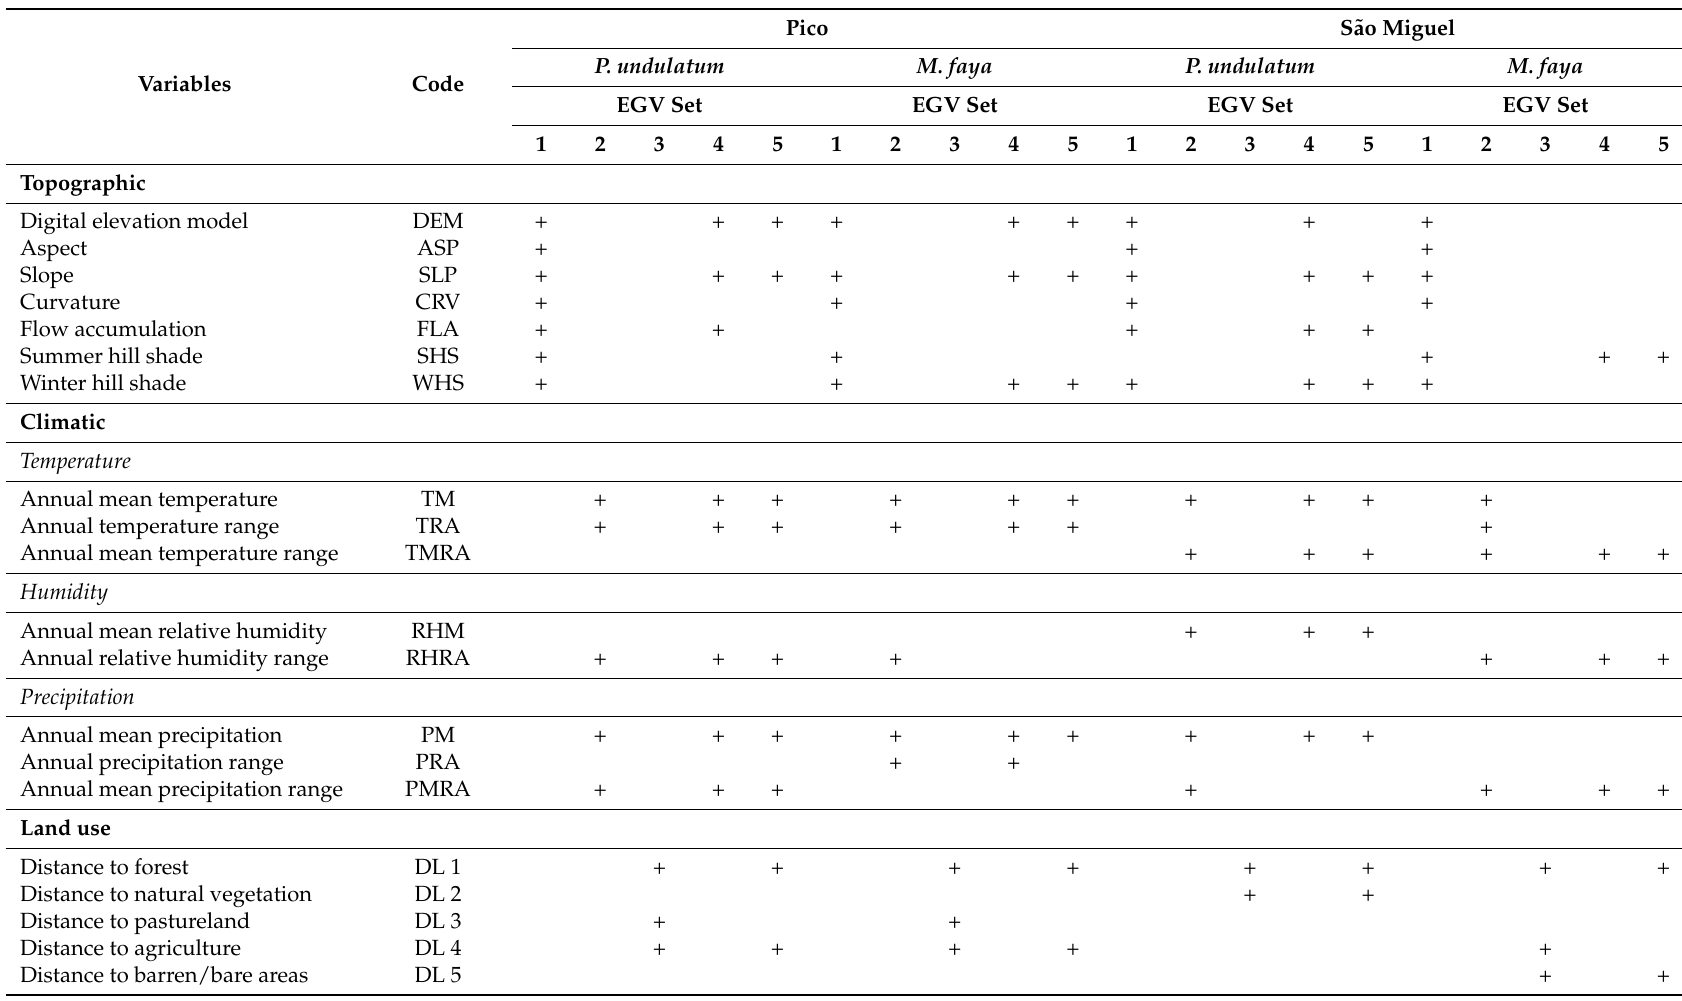
Table 3. Sets of EGV (1–5) that produced models with highest fit in Pico and S ã o Miguel islands using fixed effects GLMs.